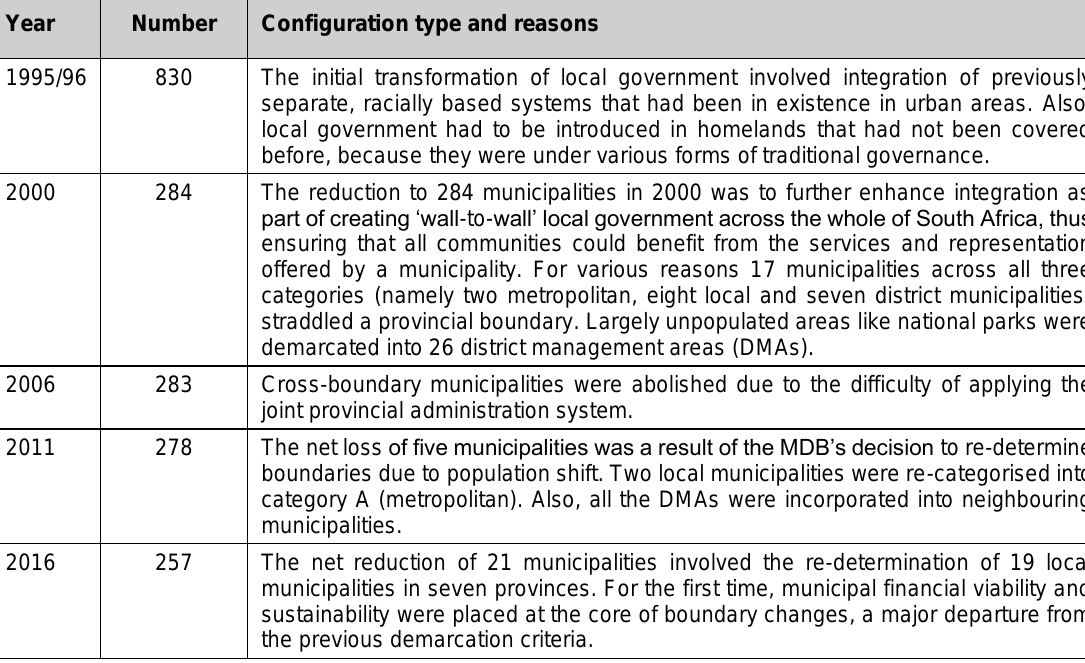
Table 2: Reasons behind the reduction in the number of